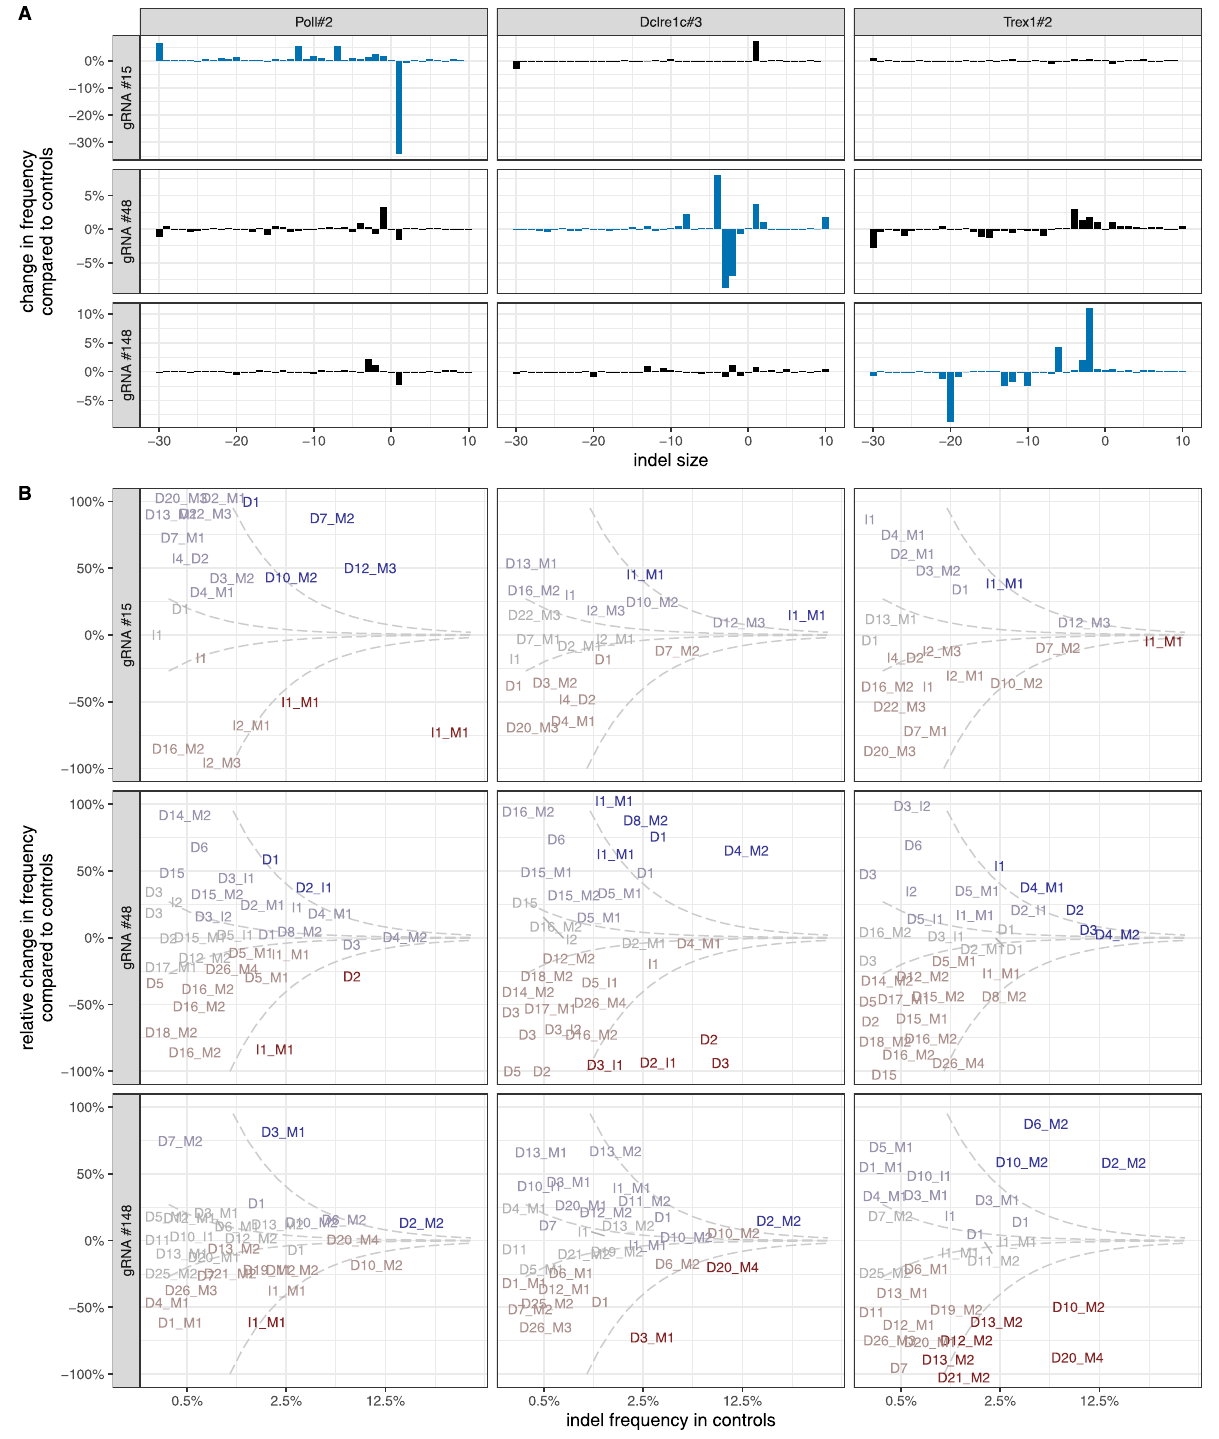
Fig. 3 De fi ciencies in specialized DNA damage repair genes in fl uence indel pro fi les in a locus-speci fi c manner. A Indel pro fi le divergence between controls and selected clones. Blue bars highlight clone/gRNA combinations that were signi fi cantly affected (FDR-corrected p < 0.01 from a chi-squared distribution, see Methods). B Change in frequency of individual indels relative to controls. 'D' = deletion, 'I' = insertion, 'M' = microhomology (see Methods). X axis indicates the frequency in control clones. Y axis indicates relative change in indel frequency in a given clone relative to control clones. Complete loss of the indel is at − 100%, while 100% indicates doubled frequency. The axis is truncated there for display clarity. Only indels present at 0.3% frequency or higher in control clones are shown. Dashed lines indicate absolute change of 0.1% and 1% respectively, color gradations highlight this change. Biological replicates ( N = 2) were averaged for clarity. All columns relate to the same gRNAs as in panel ( A